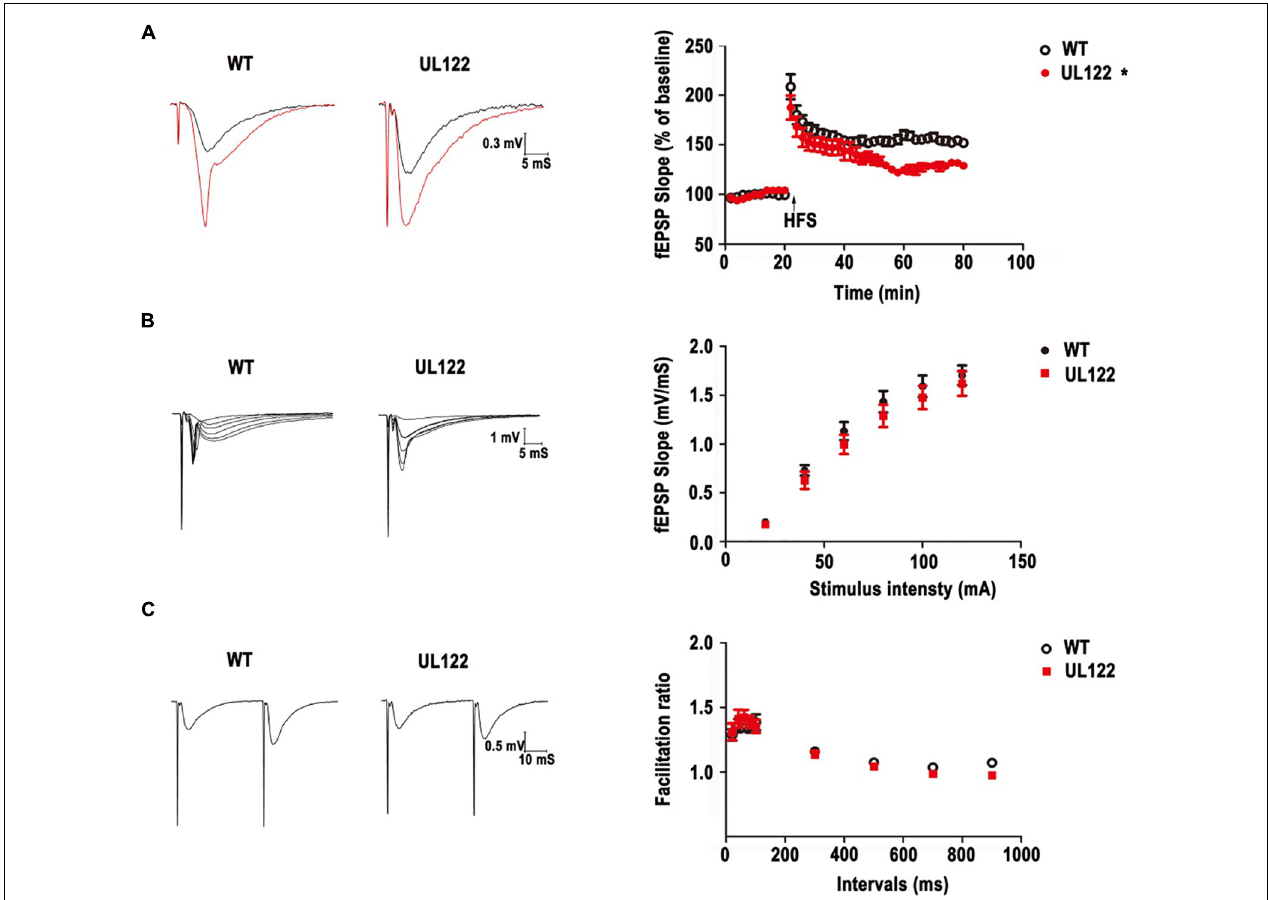
FIGURE 5 | LTP impairment and basal synaptic transmission in WT mice and UL122 mice. (A) Representative traces before (black line) and after (red line) LTP inductions. HFS–induced LTP in hippocampal CA1 neurons from WT mice. * P < 0.05 vs. WT group. (B) The input-output curves at the SC-CA1 pathway in hippocampal slices from WT mice and UL122 mice. n = 10/8 (10 slices from 8 mice) for WT mice, n = 11/8 (11 slices from 8 mice) for UL122 mice. (C) Paired-pulse facilitation at the SC-CA1 pathway in hippocampal slices from WT mice and UL122 mice. n = 10/8 for WT mice, n = 11/8 for UL122 mice. Data were expressed as mean ± SEM. Comparison was made by two-way or one-way analysis of variance. *The slope of EPSPs in the maintaining stage of UL122 mice group was significantly decreased than that of WT